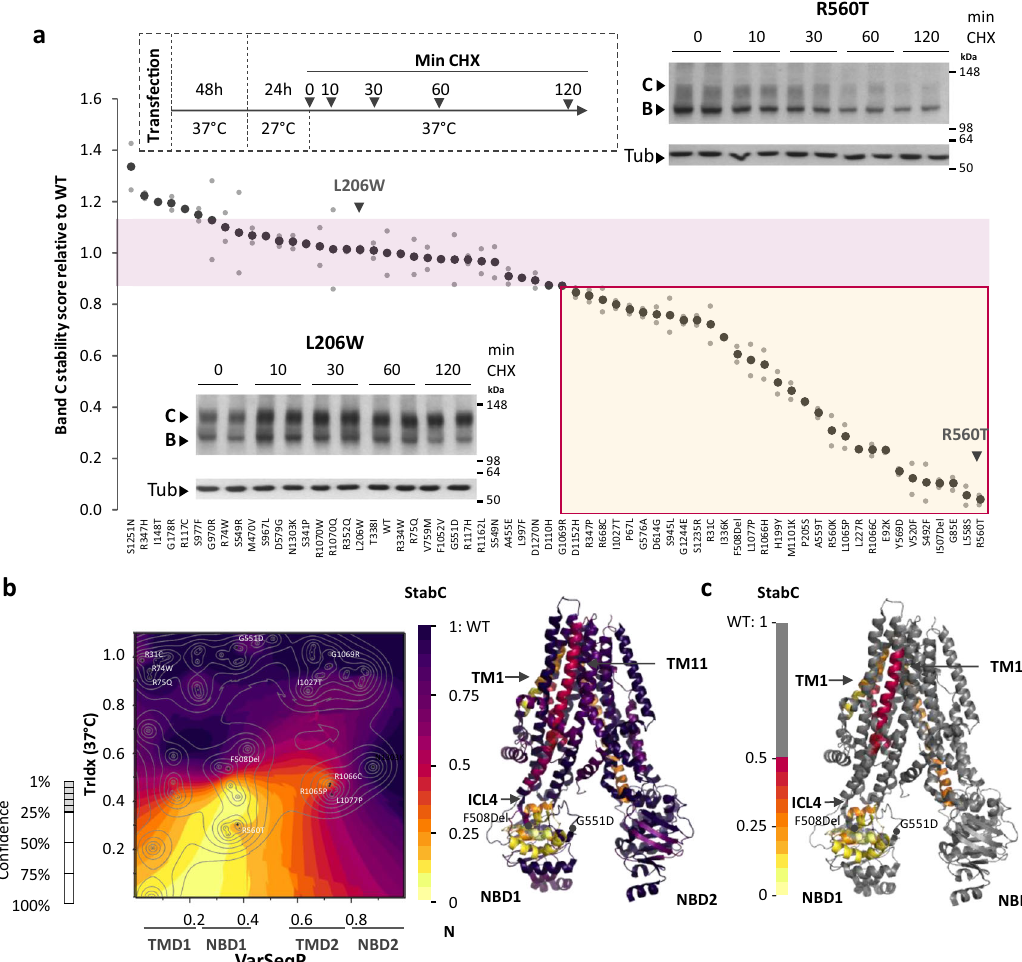
Fig. 4 SCV relationships de fi ning stability at the cell surface. a The % of band C stability relative to WT of each variant at 37 °C was assessed after 24 h incubation at 27 °C followed by 120 min at 37 °C in the presence of CHX to inhibit protein synthesis ( n = 2 biological replicates). Variants are ordered from the most to the least stable. The red box highlights variants that are destabilized relative to WT stability. SDS-PAGE of L206W (lower left insert) and R560T variants (upper right insert) following treatment with CHX for 0,10, 30, 60, and 120 min are shown as examples of WT-like stability and low- stability variants, respectively. b (Left panel) Stability of band C (StabC)-phenotype landscape using the VSP-predicted values of band C stability relative to WT ( z -axis) relating to TrIdx (band C/total (B + C) ratio; y axis) to the sequence position (VarSeqP, x -axis) overlaid with the con fi dence contour intervals. (Right panel) The StabC-phenotype landscape de fi ned functional structure. c Grayout of panel B, StabC functional structure showing only residues with <50% of WT measured value. The grayout structure highlights in a color gradient the known and predicted unknown residue functions that are likely to contribute to disease due to reduced stability at the cell